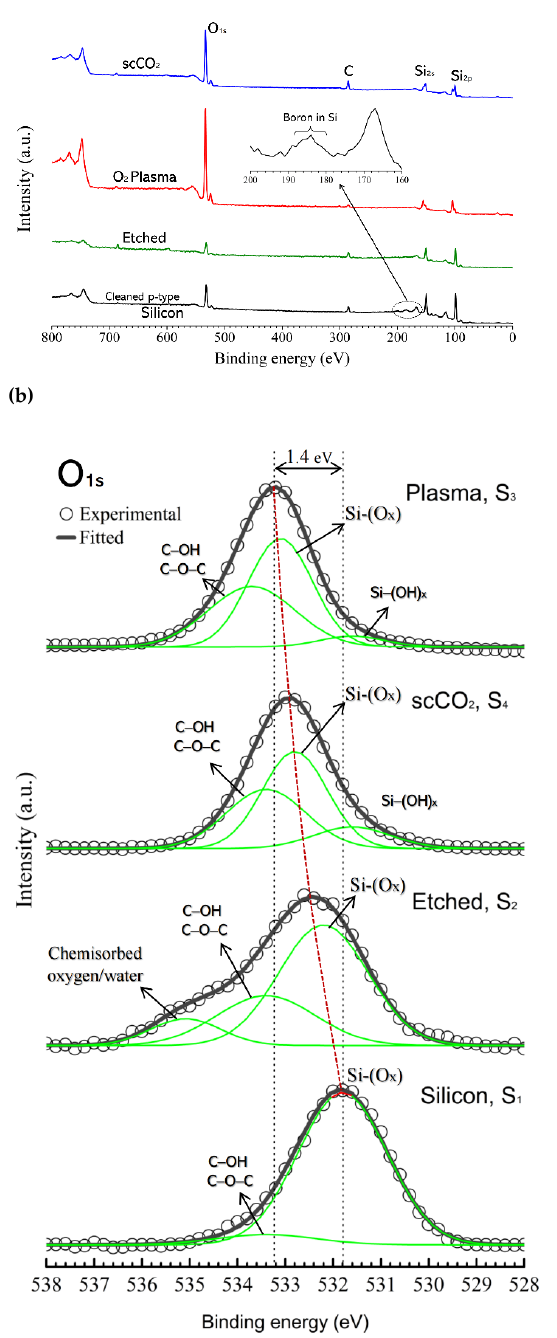
Figure 2. ( a ) XPS wide-scan spectra for cleaned p-type silicon and after etching and treatment with O 2 plasma or scCO 2 . ( b ) Deconvolution of XPS spectra of O 1s for different samples.